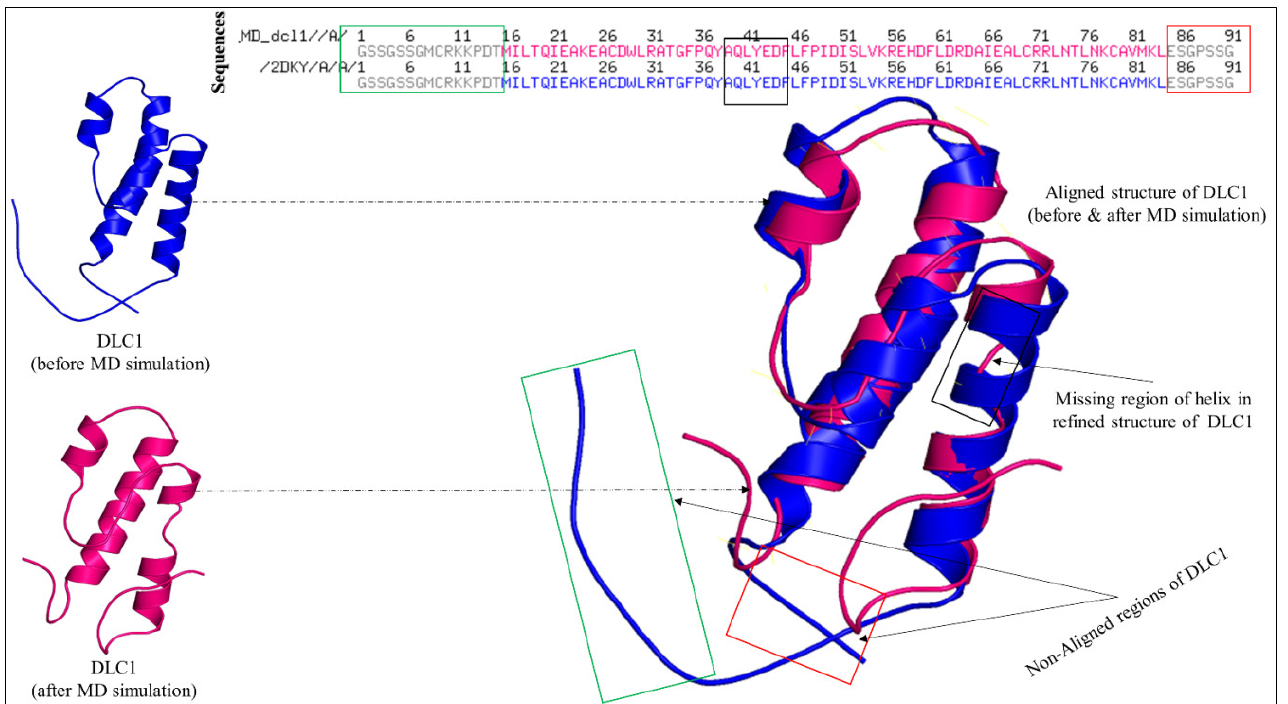
Figure 6. Aligning the before and after molecular dynamics-simulated structures of DLC1. There were a few regions in the refined structure that did not align perfectly with the original DLC1 protein.